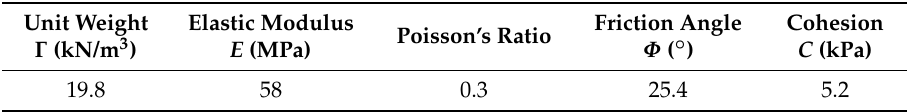
Table 1. Properties of the soil in the model test.